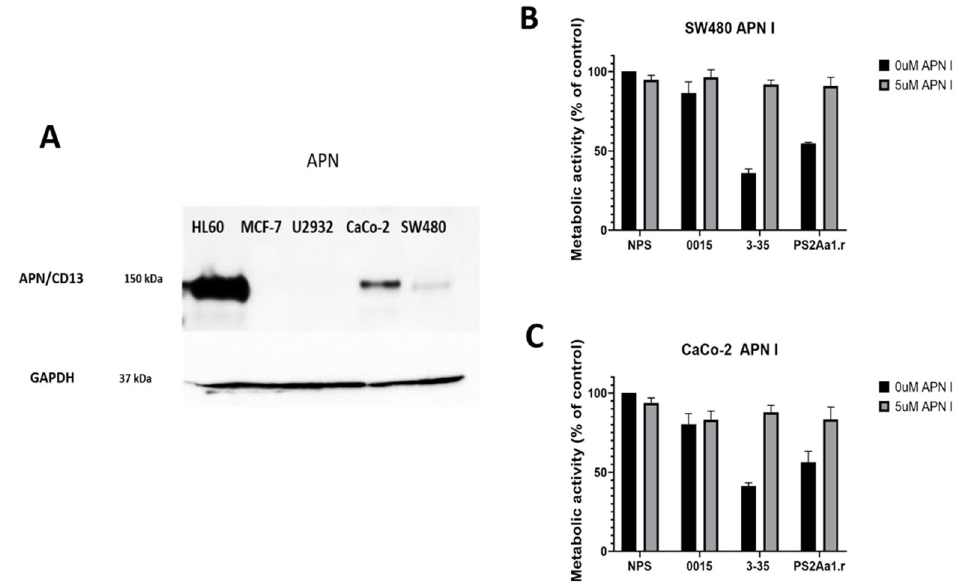
Figure 4. ( A ) Detection of APN receptor in different cell lines HL60, MCF ‐ 7, U2932, CaCo ‐ 2, and SW480. Metabolic activity of ( B ) SW480 and ( C ) CaCO ‐ 2 without parasporin (NP), parasporin 0015, 3 ‐ 35, and the recombinant of PS2Aa1 (PS2Aa1.r) at 5 μ g ∙ mL − 1 in the presence or absence of the APN inhibitor.